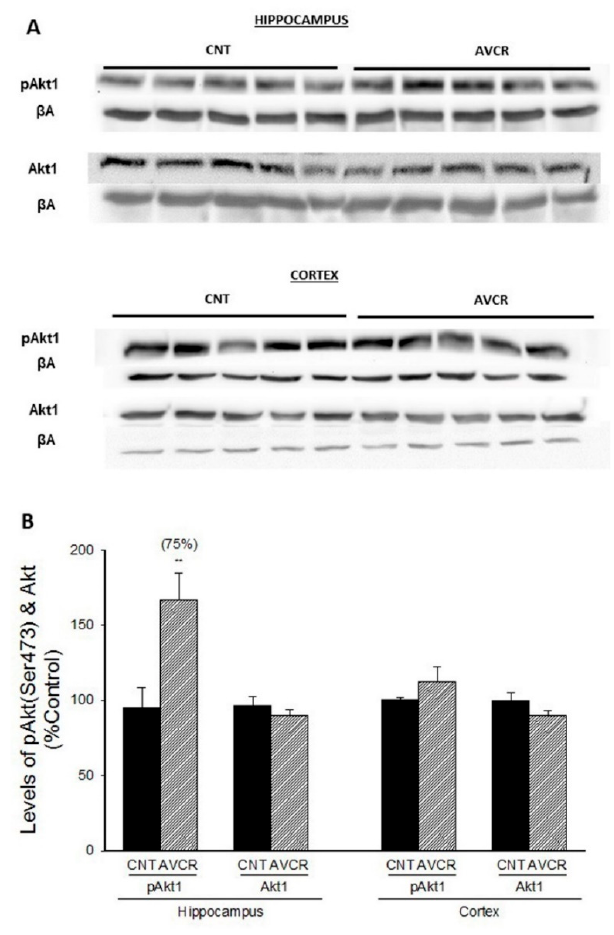
Figure 1. Effects of AVCRI104P3 on pAKt (Ser473) and Akt in the hippocampus and cortex of 12-month-old 129/Sv × C57BL/6 male mice. ( A ) Representative Western blot images of pAKt (Ser473) and Akt β -actin were used as internal control. ( B ) Photodensitometric quantification of WB experiments was used to evaluate changes in pAkt (Ser473) and Akt expression. The results are the mean ±